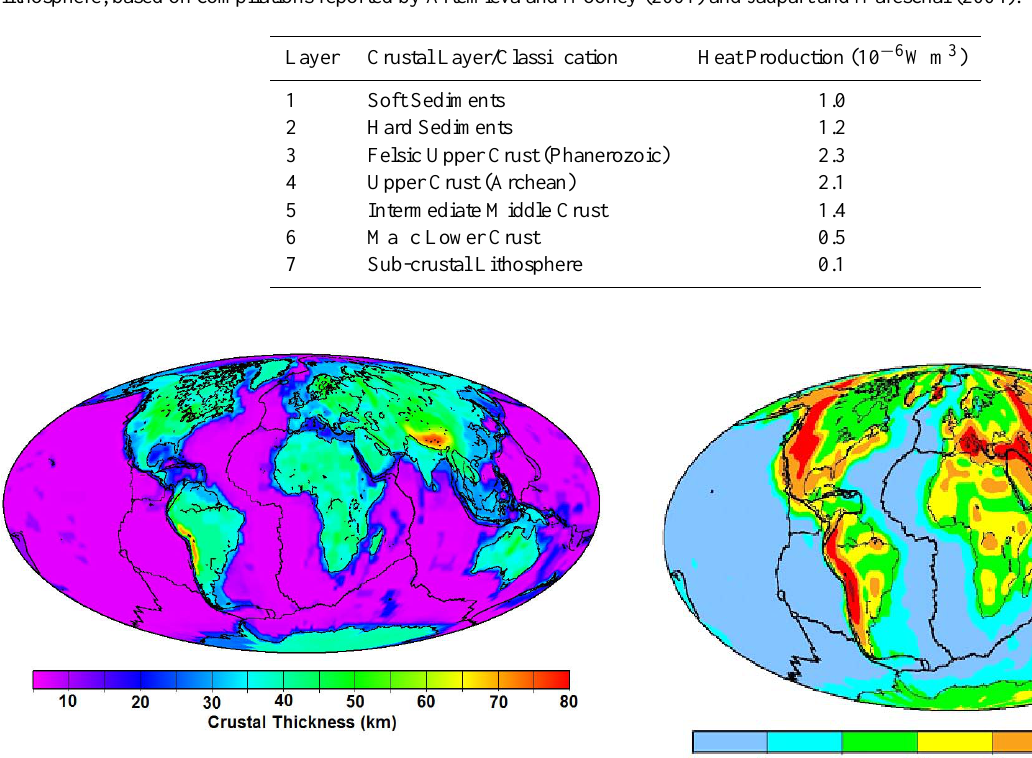
Table 2. Mean radiogenic heat production values adopted in the present work for the system of layers constituting the structure of the lithosphere, based on compilations reported by Artemieva and Mooney (2001) and Jaupart and Mareschal (2004).